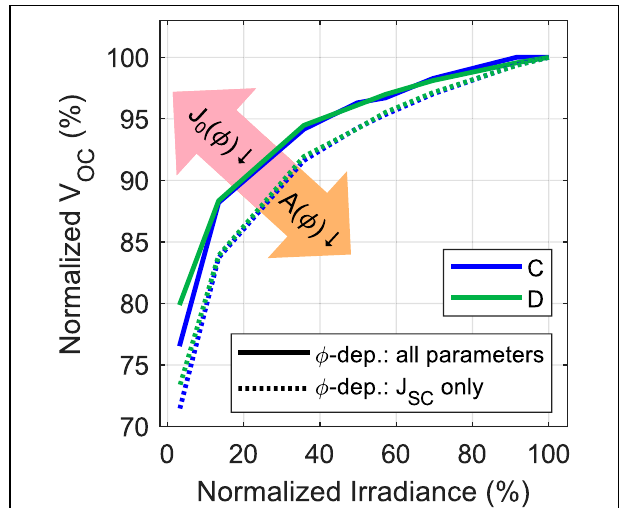
FIGURE 4 | Modelling the V OC of cell types C (blue) and D (green) including the irradiance dependence of either all parameters (solid lines) or of J SC only (dotted lines).